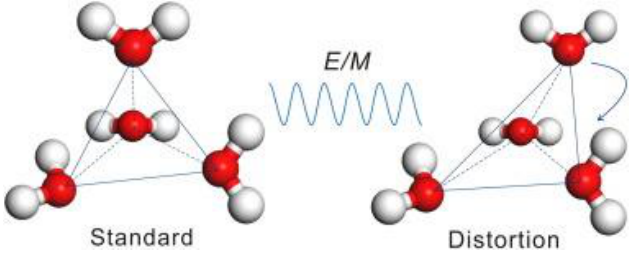
Figure 7. Schematic illustration of the tetrahedral structure of water before and after microwave irradiation.